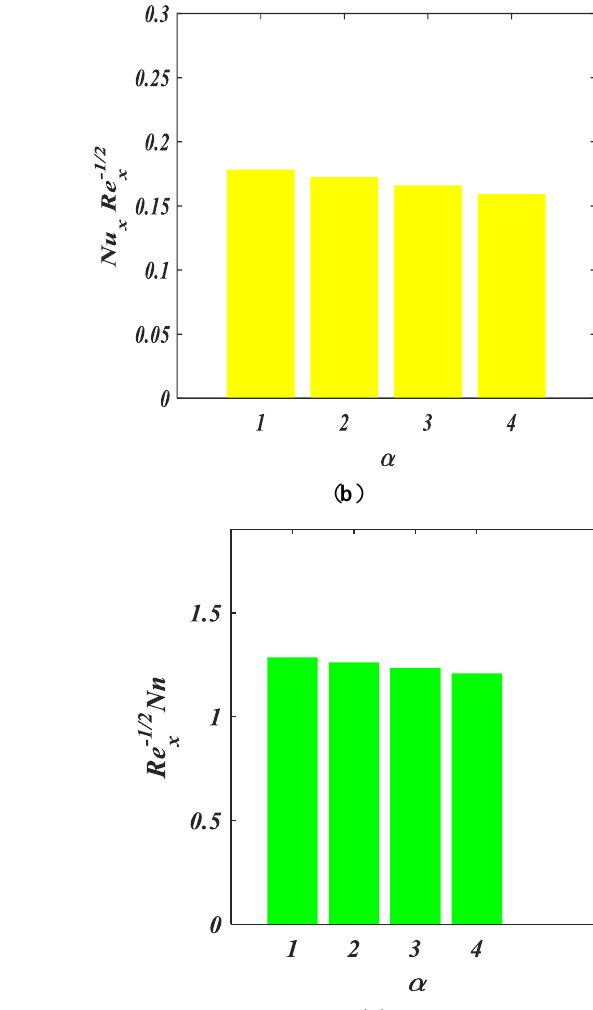
Figure 12. ( a – d ) Fluctuation in bar graphs for 𝑅𝑒 𝑥1/2 𝐶𝑓 𝛼 .